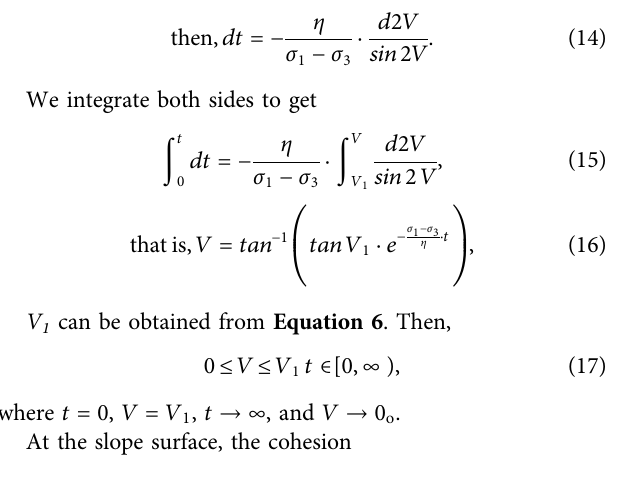
Frontiers in Earth Science |